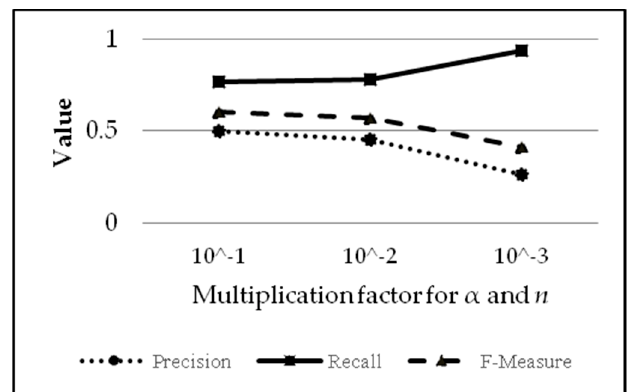
Figure 6. Effect of variation in the alpha and n values at information retrieval measurement values from the evaluation of a plagiarism detection system using the learning vector quantization algorithm.